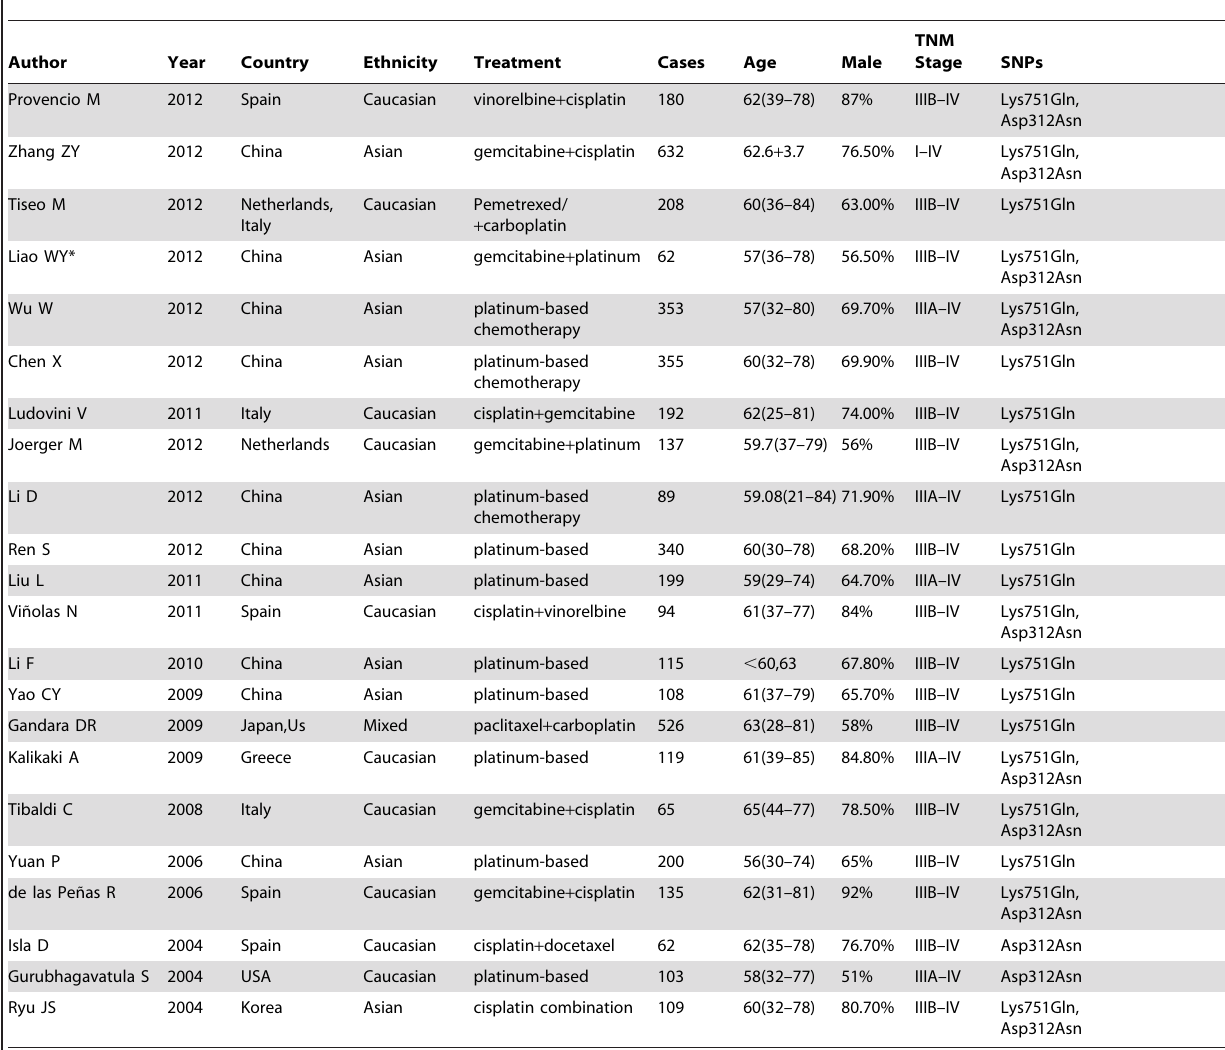
Table 1. Baseline characteristics of included